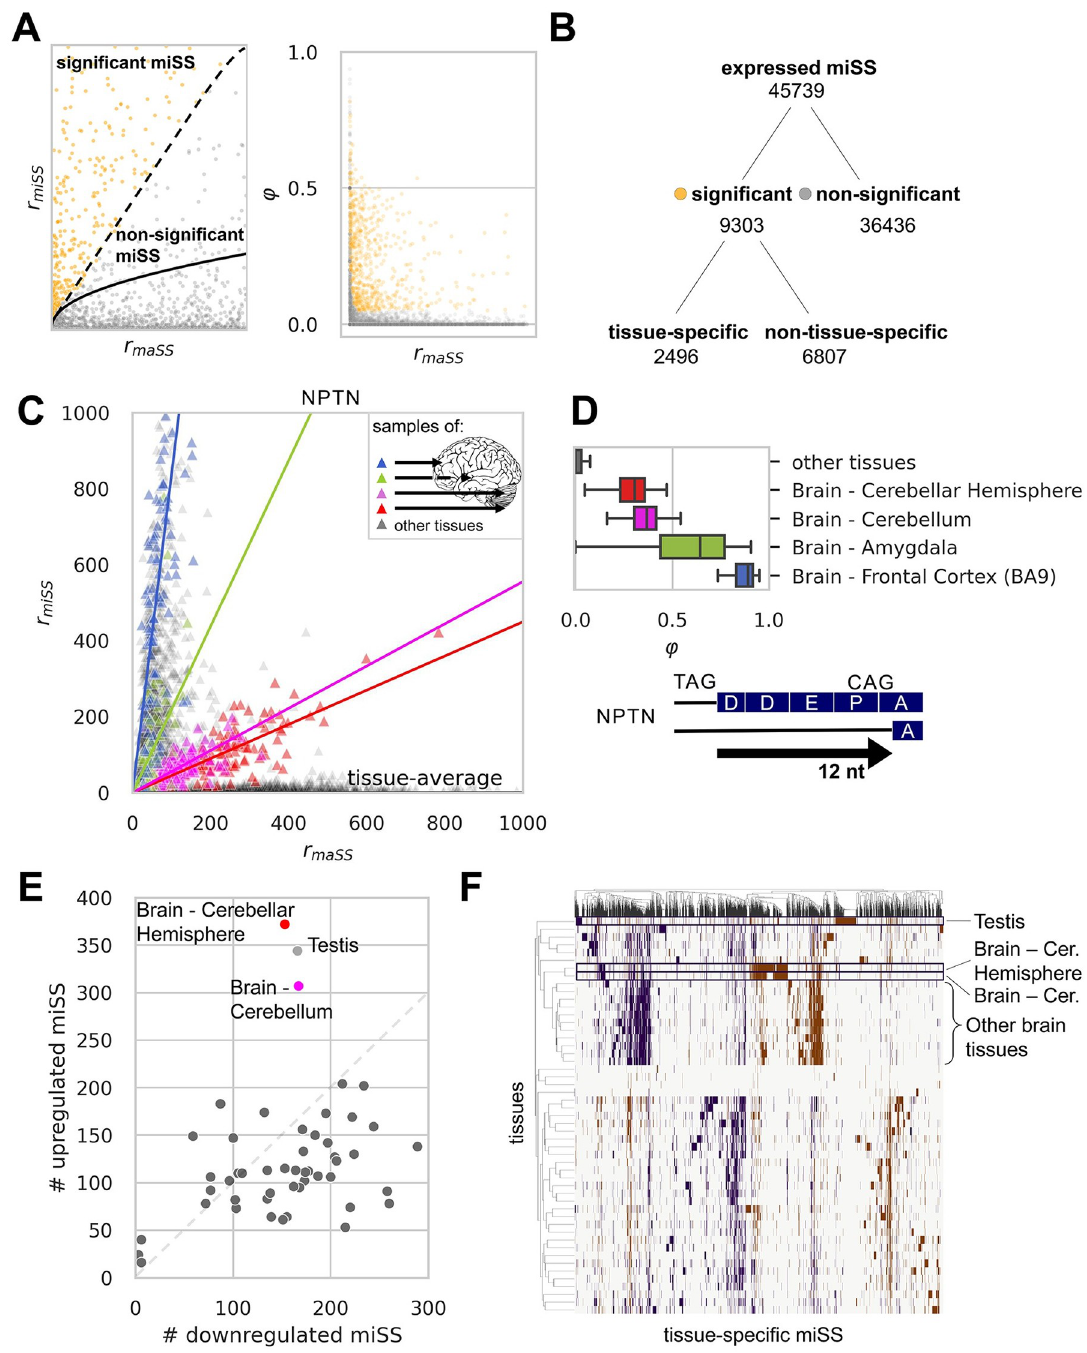
Fig 2. Expression of miSS in human tissues. (A) Zero-inflated Poisson model of miSS expression relative to maSS enables identification of significantly expressed miSS (left). Each dot represents a miSS. The expected values of r miSS are shown by the solid curve. FDR cutoff of 5% is shown by the dashed curve. The φ value decreases with increase of r (right). (B) The classification of maSS expressed miSS. (C) Tissue-specific expression of a miSS in the NPTN gene. Each dot represents a sample, i.e. one tissue in one individual. Tissue specificity is estimated by a linear model with dummy variables corresponding to tissues. (D) The distribution of NPTN miSS φ values in selected tissues (top). The indel caused by NPTN miSS results in the deletion of DDEP motif from the aminoacid sequence (bottom). (E) The number of tissue-specific (up- or downregulated) miSS in each tissue. (F) The clustering of tissue-specific miSS and tissues based on φ values. Blue and red points correspond to downregulated and upregulated miSS, respectively.